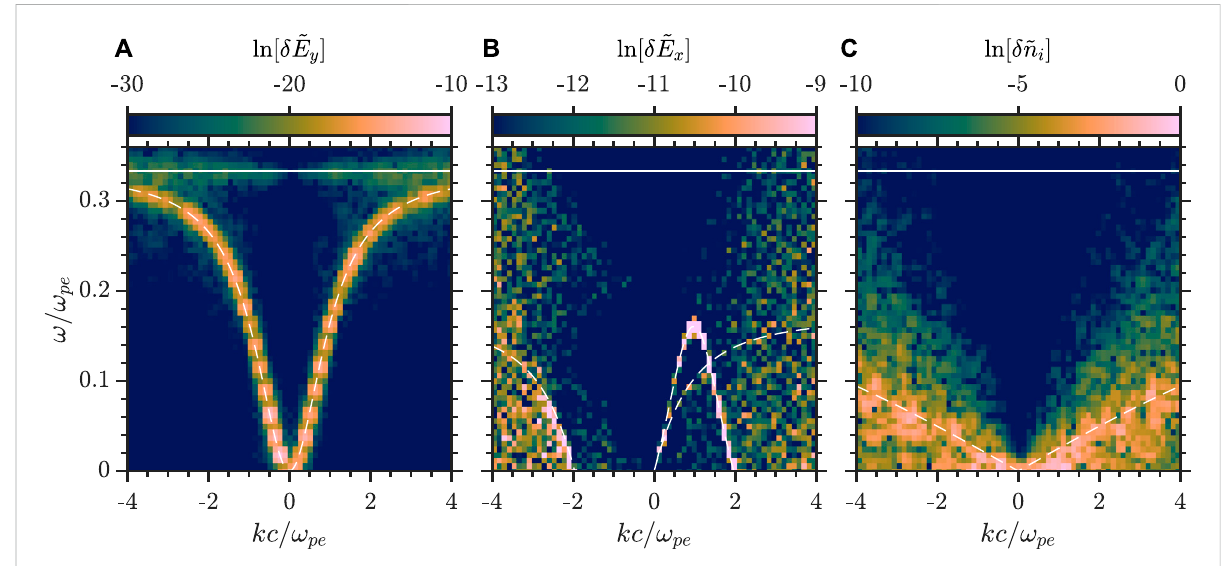
FIGURE 2 (A) Whistler branch visible in δ ~ E y in a cold electron, fi xed ion simulation. (B) Ponderomotive coupling pattern in δ ~ E x for a low amplitude pump whistler( δ B w / B 0 =0.1)inacoldelectron, fi xedionsimulation. (C) Ionacousticbranchseenin δ ~ n i inahotelectron,coldionsimulation( T e / T i =100).The solid line in each is ω ce / ω pe and the dashed curves represent the respective branch shown in each